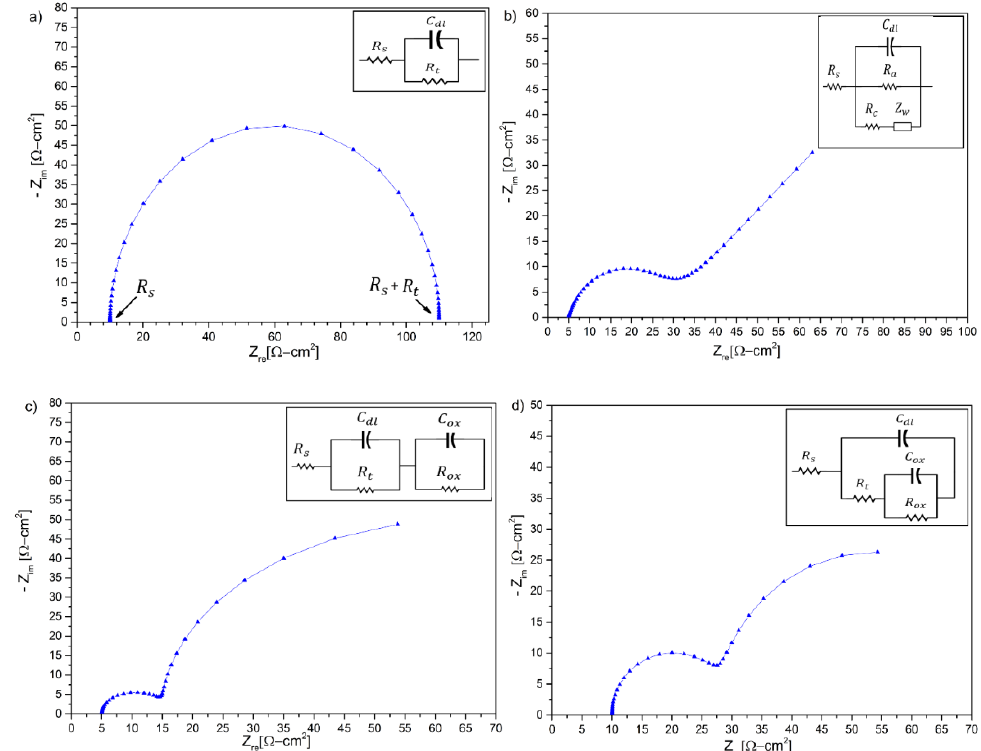
Figure 1. Nyquist plots and the equivalent circuits representing the corrosion of metals in molten salts. ( a ) Representation of a non ‐ active metal; ( b ) active metals forming a porous scale; ( c ) active metals forming a protective scale; ( d ) active metals suffering from localized corrosion. (Adapted from [21]).